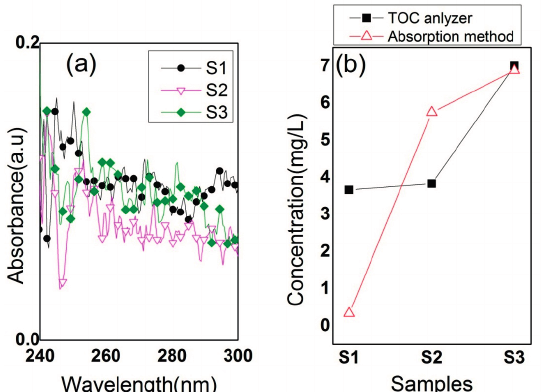
Figure 5. ( a ) UV absorbance spectra for three different real samples (S1: tap water, S2: sea water, and S3: river water). ( b ) Comparison of TOC concentrations based on UV absorbance with those measured by the TOC analyzer instrument. S2 and S3 samples were collected from the South Sea, and the Gwangju stream in Korea,